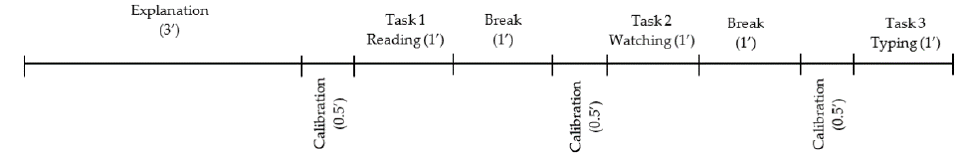
Figure 2. Experiment process from explanation to the third task.